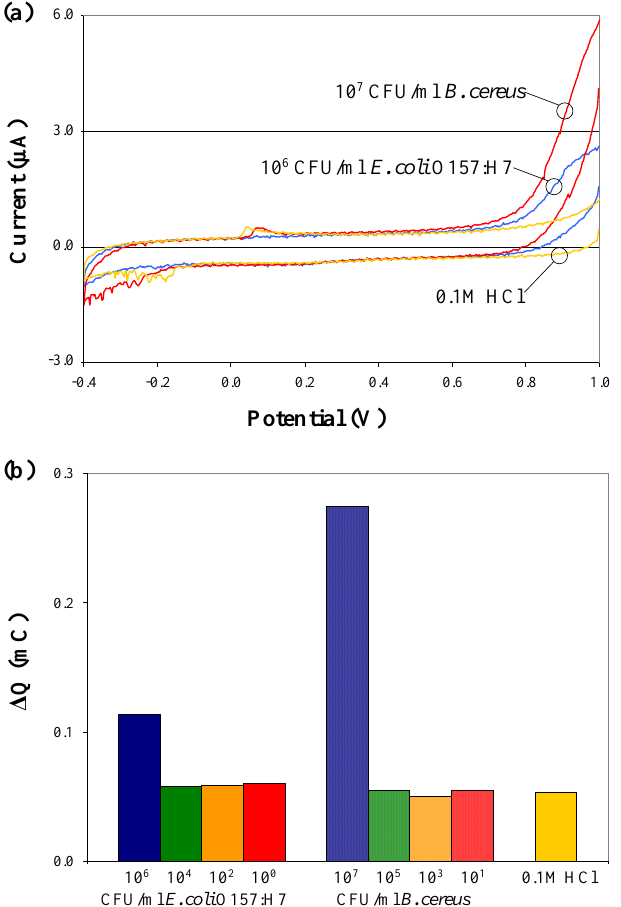
Figure 4. Cyclic voltammograms ( a ) and charge transfer values; ( b ) for electrochemical tests performed on pure B. cereus and E. coli O157:H7 cells, suspended at various concentrations in 0.1 M HCl solution, in the absence of